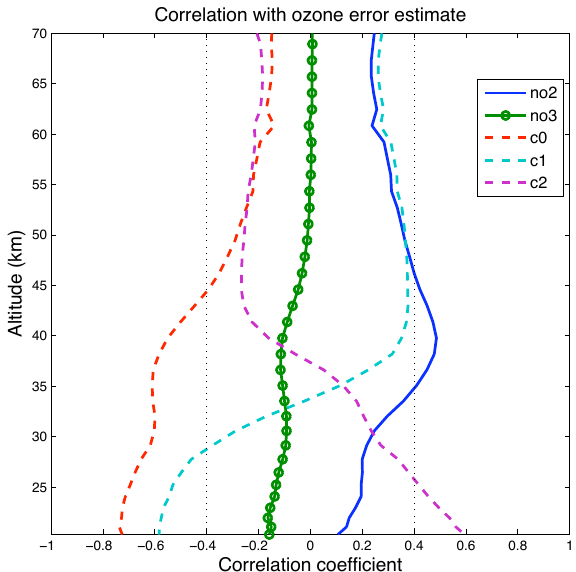
Fig. 7. Examples of correlation coefficients between the error esti- mates of horizontally integrated O 3 and NO 2 (solid blue line), NO 3 (green circles) and three aerosol parameters (dashed lines). Star 29 in